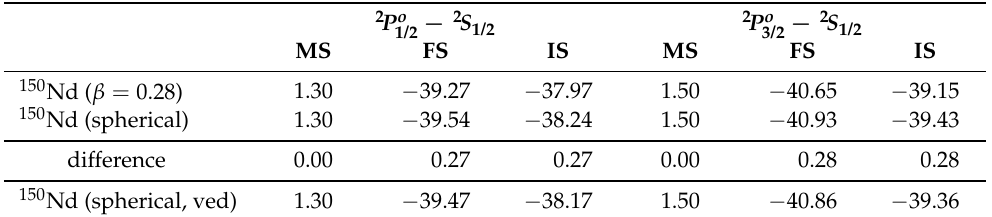
Table 13. Line frequency isotope shifts in units of meV for the 2 P o transitions in